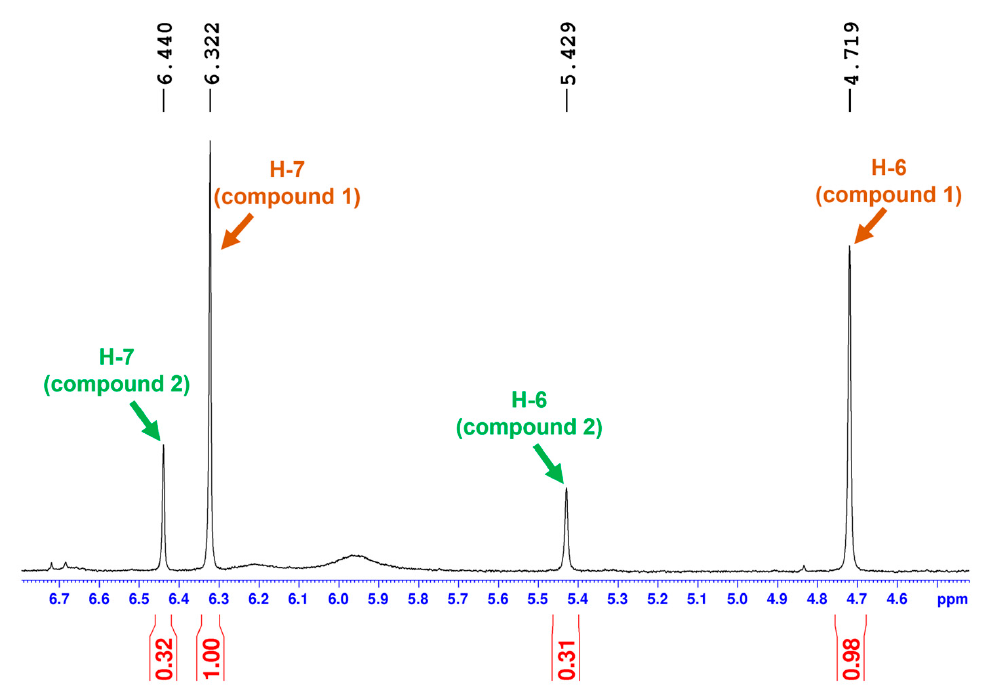
Figure 3. Epimeric ratio of the mixture of compounds 1 and 2 , deduced from the 1 H-NMR spectrum.